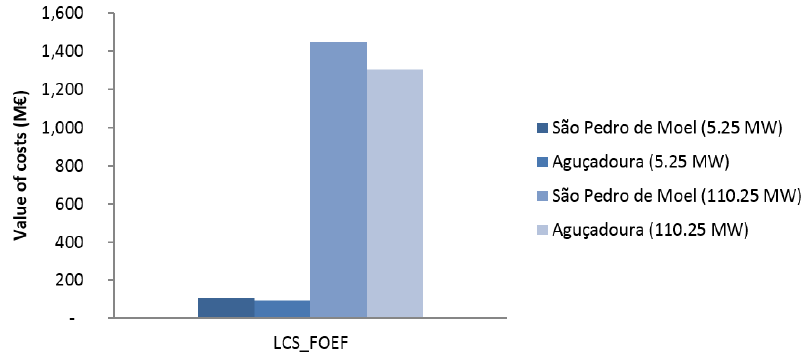
Figure 8. Life-cycle total cost of several wave farms in different locations.